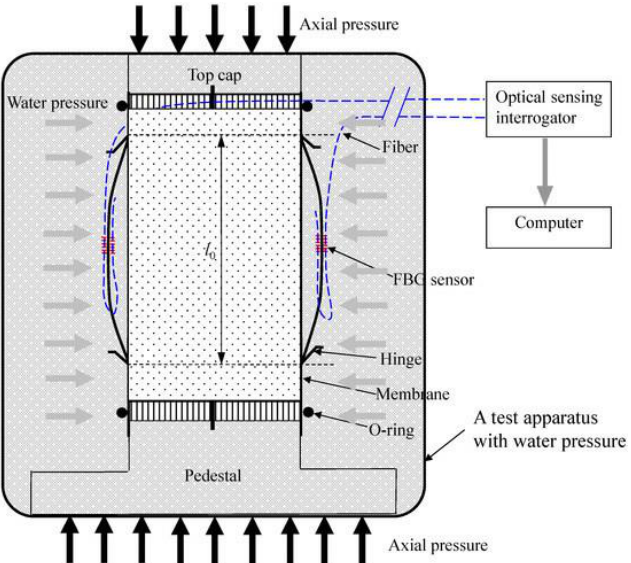
Figure 6. Schematic diagram of the SDTs on a soil specimen in a modified triaxial apparatus (after [44], available via 2009 license: CC BY 4.0). available via 2009 license: CC BY